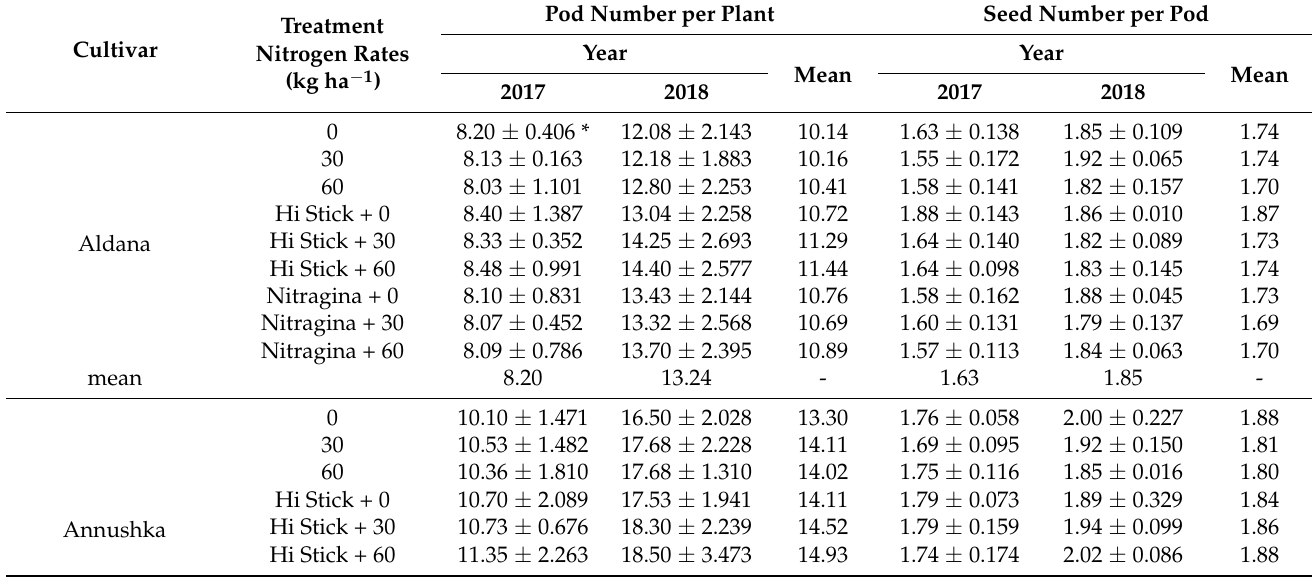
Table 3. Pod number per plant and seed number per pod depending on the mineral N fertilization applied and the